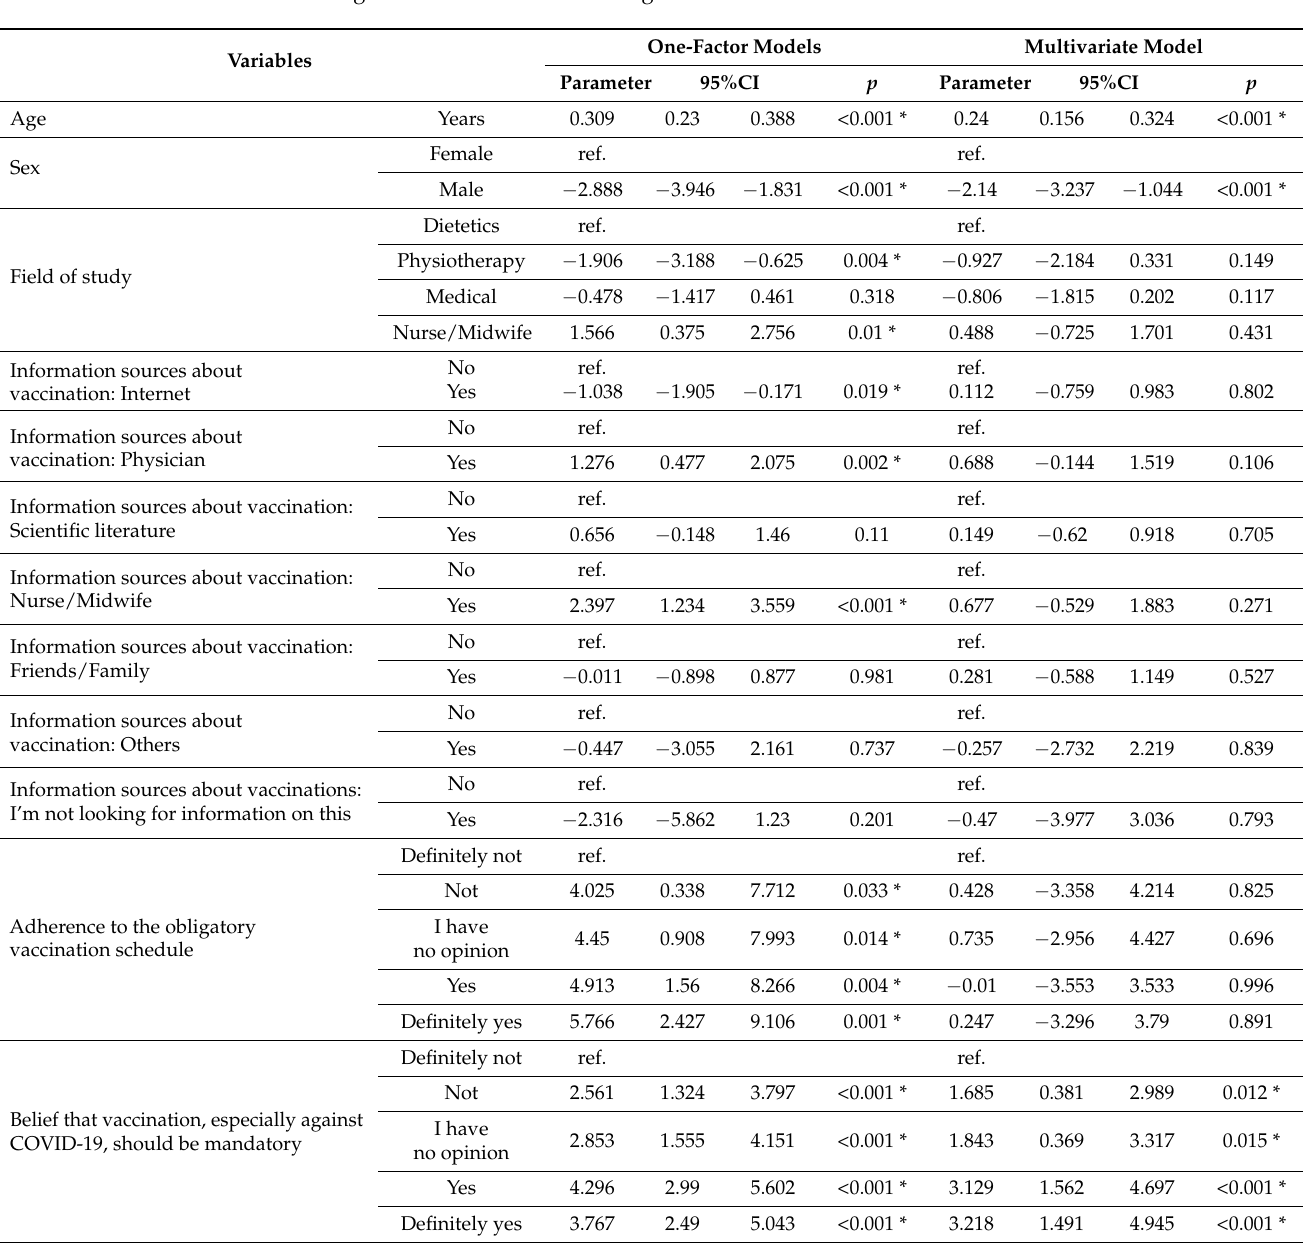
Table 3. Factors influencing the level of anxiety due to COVID-19 infection (Fear of COVID-19 Scale). Single and multivariate linear regression